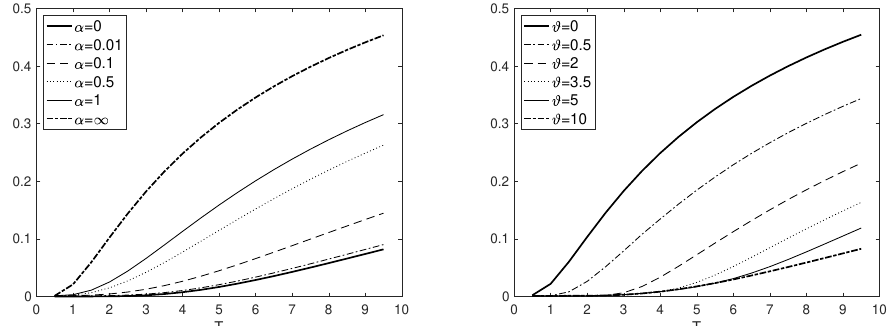
Figure 3. Graphs of default probabilities for the hazard rate ( left ) and occupation time models ( right ). The underlying firm’s value is GBM with F 0 = 100, L 0 = 50, A 0 = 20, r f = 5%, σ = 30%, γ = 5%, and N = 30. For the right graph, we used 16 terms in the Gaver–Stehfest